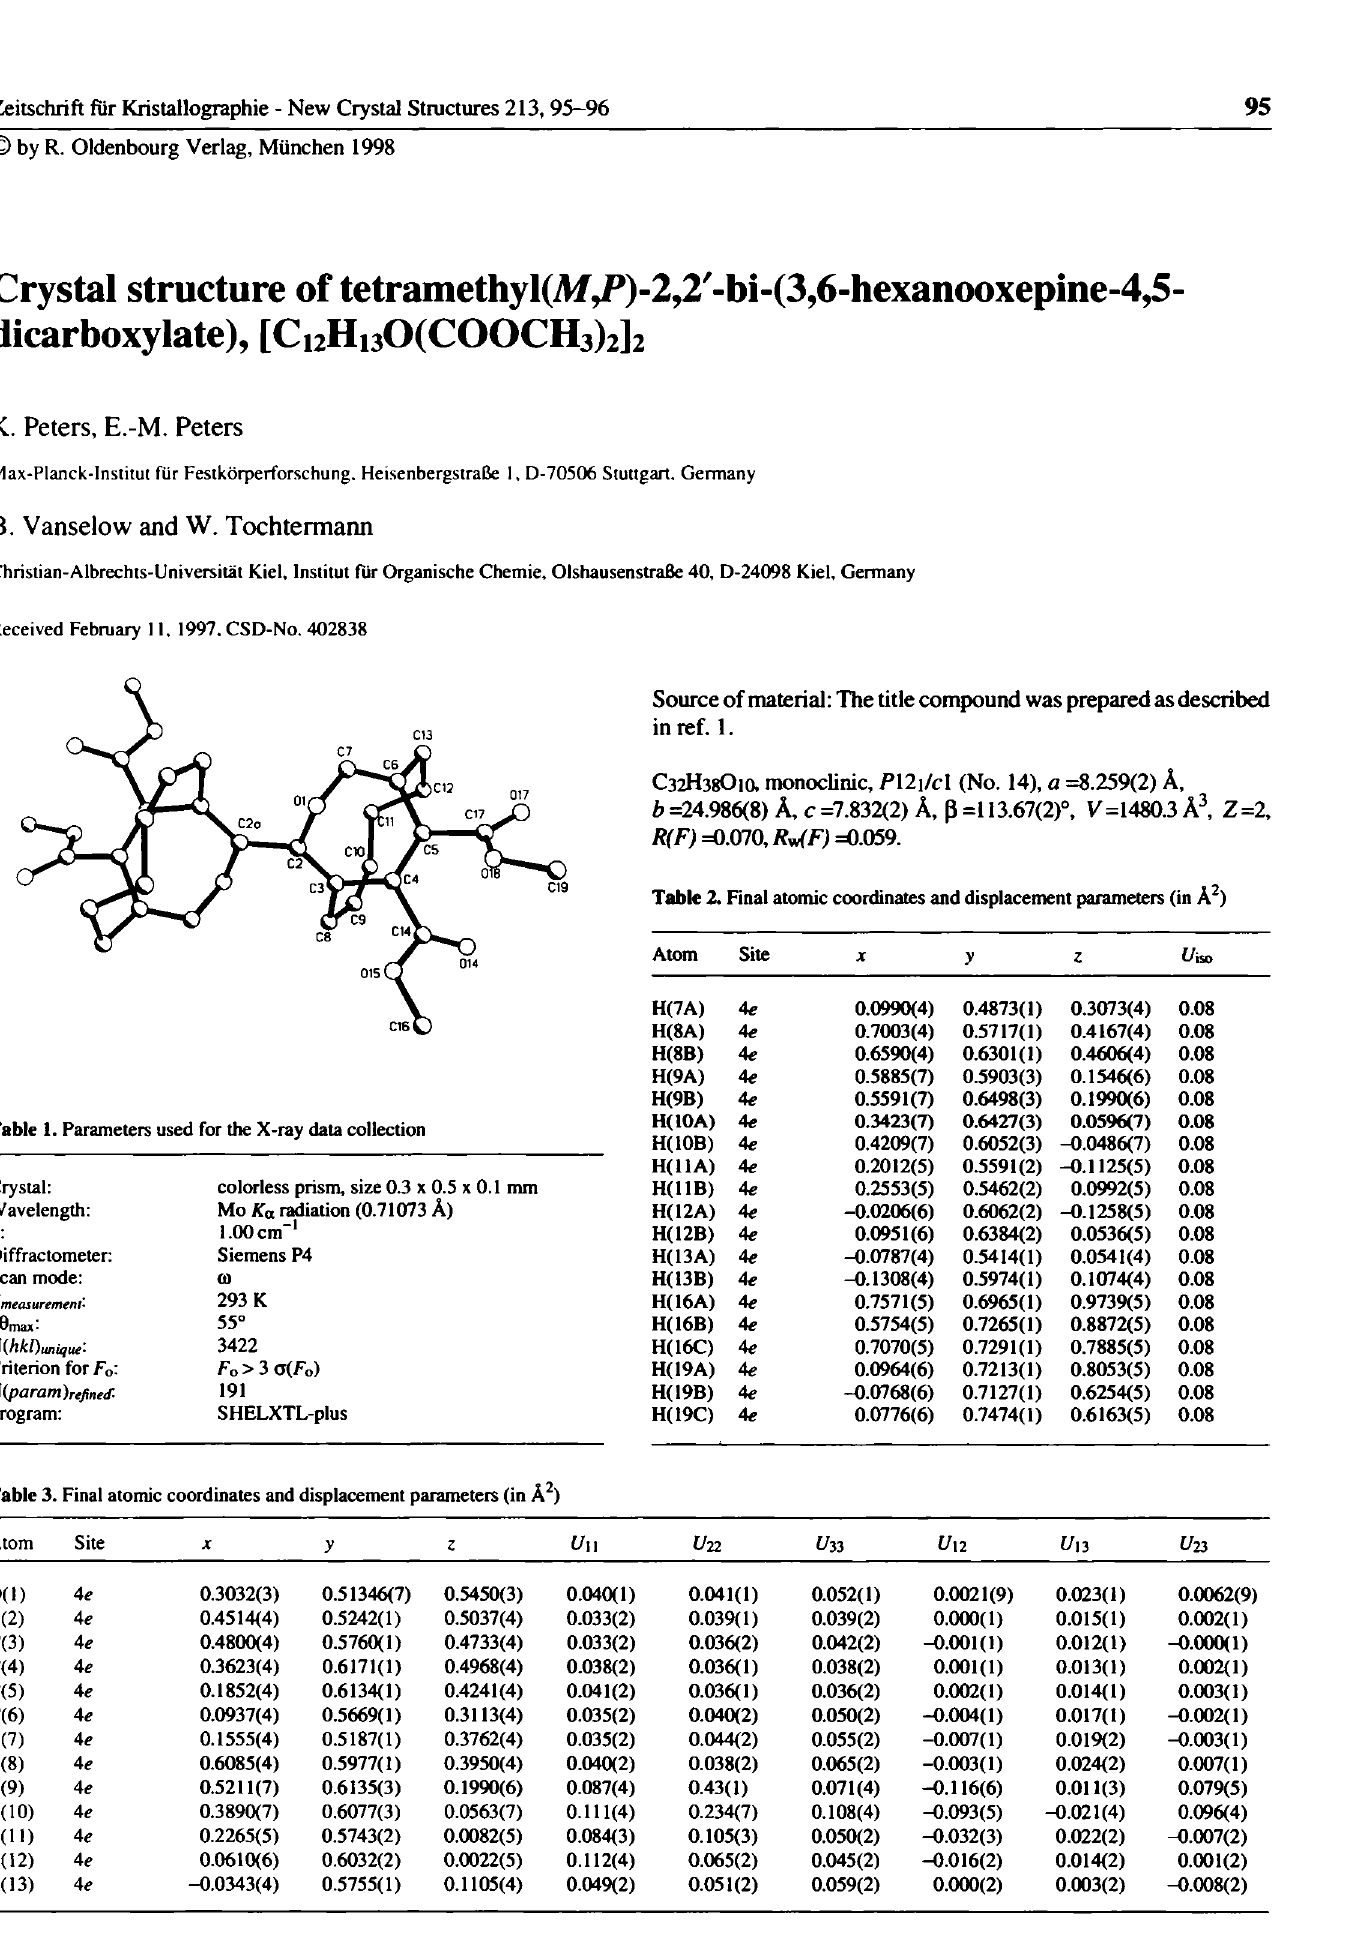
Table 3. Final atomic coordinates and displacement parameters (in Л^)